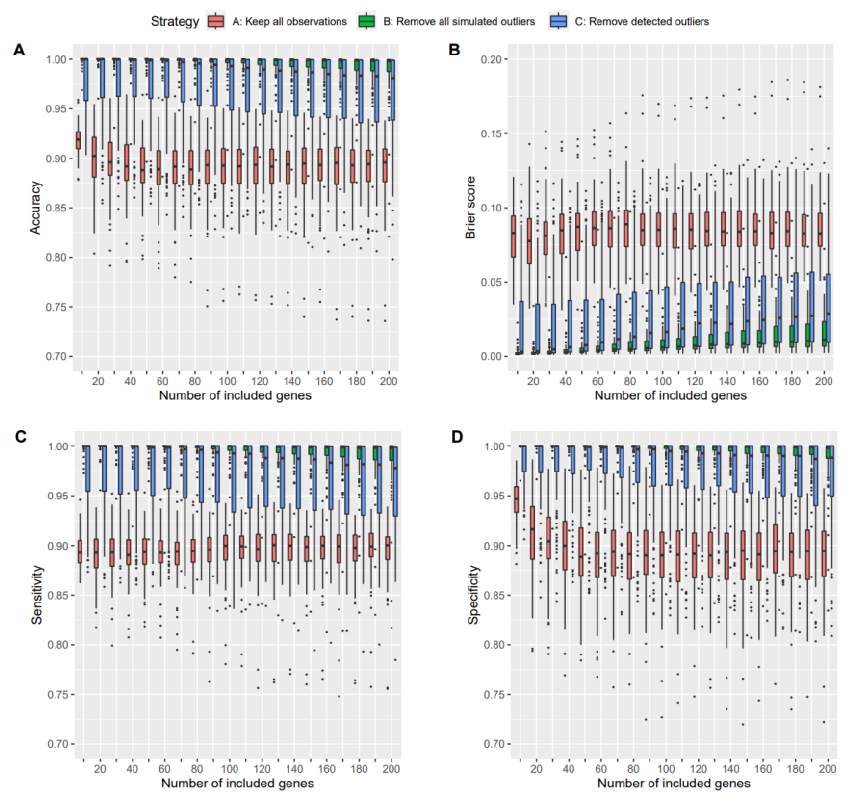
Figure 5. Performances for different outlier handling strategies. The plots show distributions of mean accuracies ( A ), mean Brier scores ( B ), mean sensitivities ( C ), and mean specificities ( D ) over 100 simulation runs, respectively, when using SVMs for classification and for different numbers of top differentially expressed genes to be included as predictors in the models. Strategy A was generally outperformed by B and